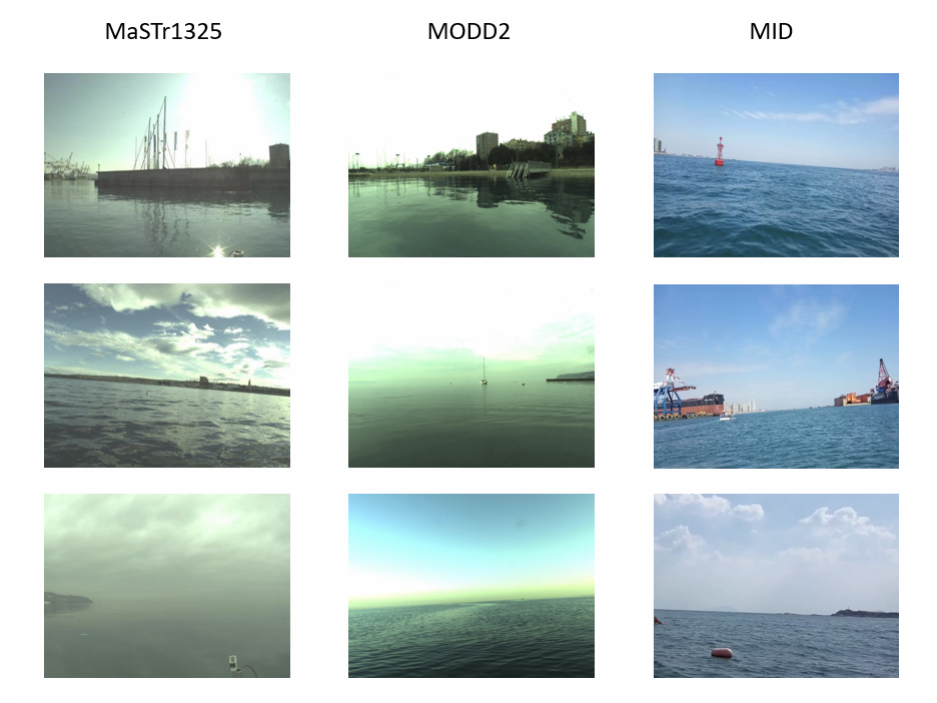
Figure 6. Some sample images from MaSTr1325, MODD2 and MID